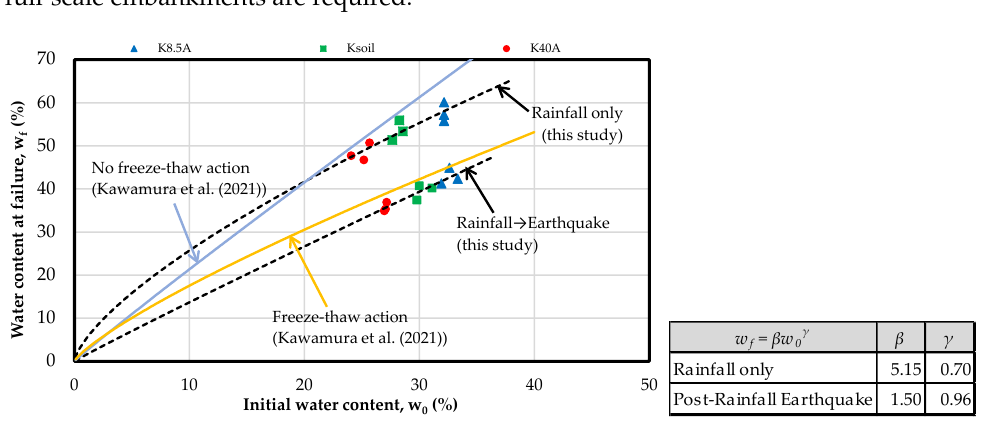
Figure 25. Relationship between water content at initial and failure conditions for Komaoka volcanic soil.